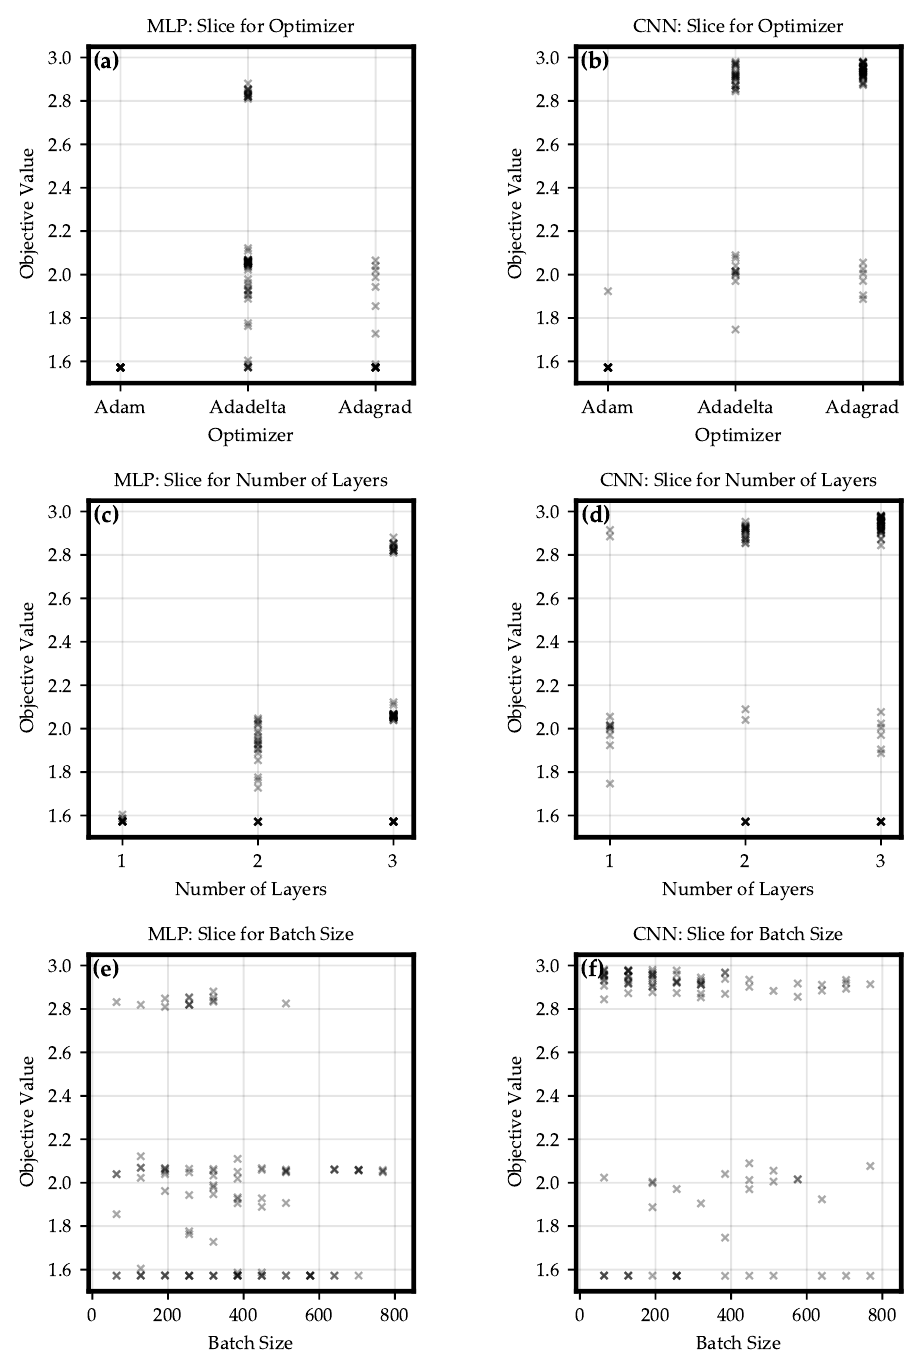
Figure 4. Comparison of the MLP- and the CNN-based hyper-parameter optimization concentrating on specific hyper-parameters. Every cross represents a single trial. The crosses are drawn partially transparent, such that points which occurred more than once during optimization appear darker. In ( a , b ) the advantage of the optimizer choices of Adagrad and Adadelta is shown. In ( c , d ) the impact of the number of layers on the objective value is presented. In ( e , f ) the influence of the window length parameter on the objective values is